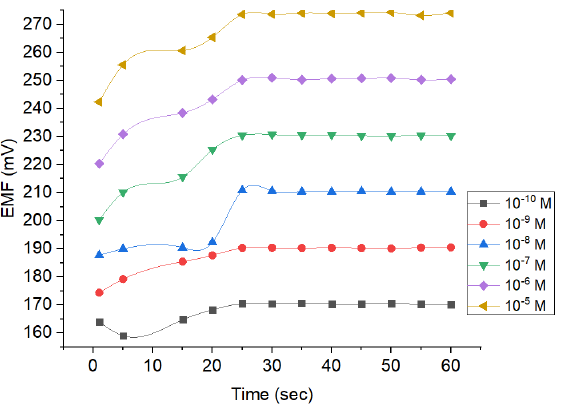
Figure 8. Response time profile of Pb 2+ ISE using different analyte concentrations.